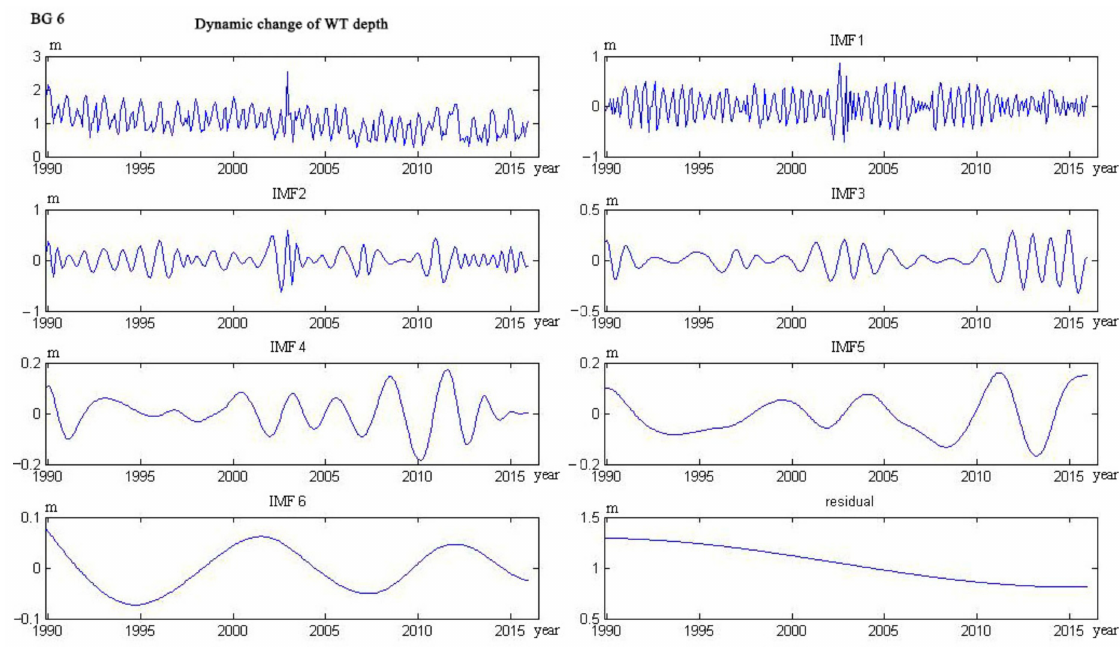
Figure A5. Decomposition of groundwater time series data of well BG6.